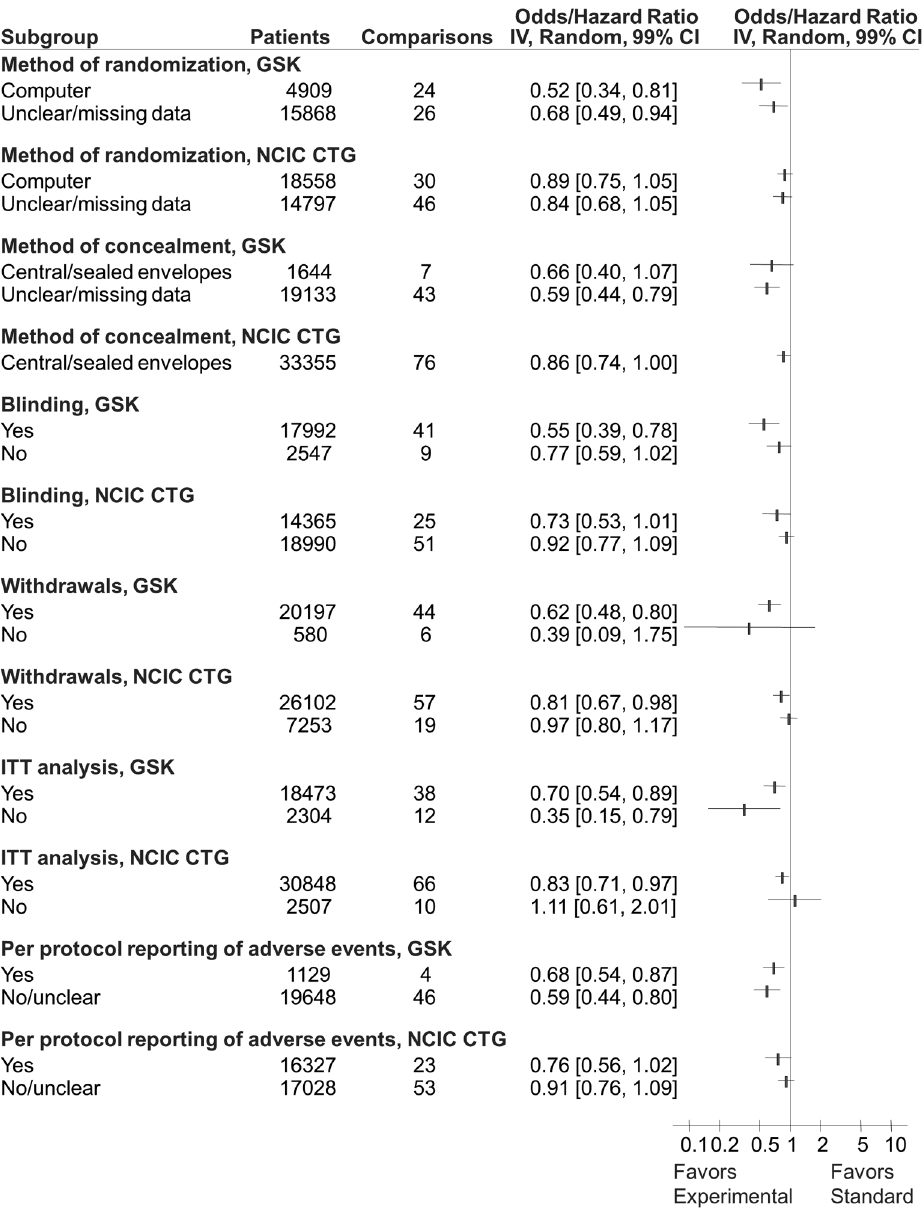
Figure 6. Forest plot of sensitivity analysis for distribution of success rate according to methodological quality of included studies for GlaxoSmithKline (GSK) and National Cancer Institute Canada Clinical Trials Group (CTG) cohorts. The summary pooled estimate (odds/hazard ratio) is indicated by rectangles, with the lines representing 99% confidence intervals (CIs).